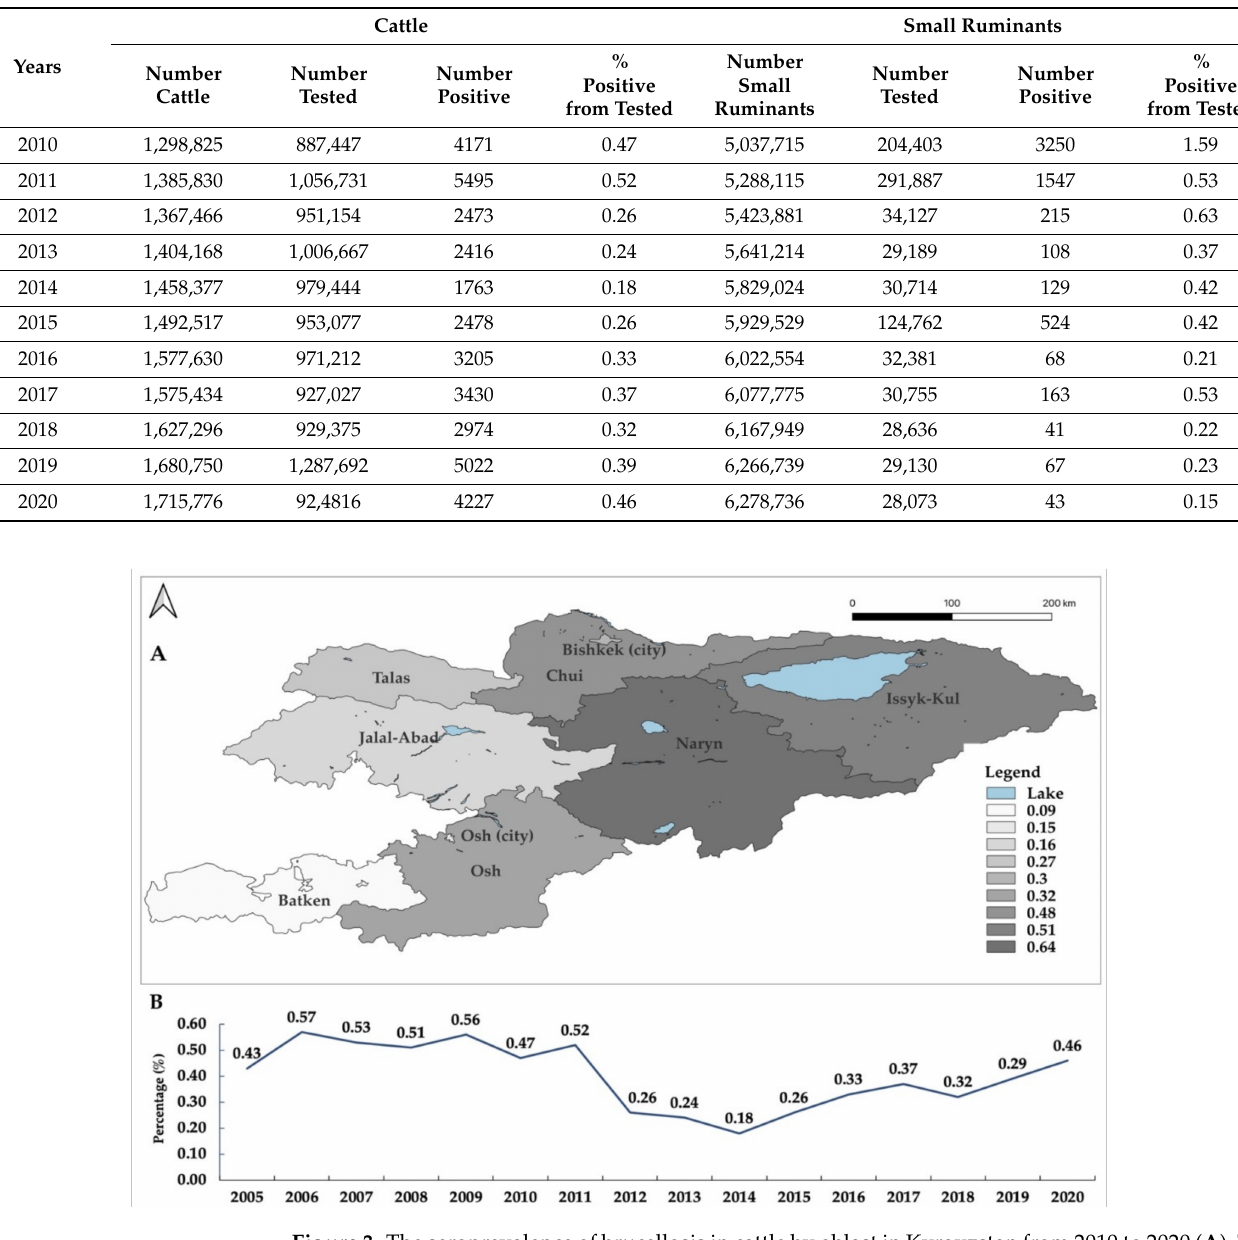
Figure 3. The seroprevalence of brucellosis in cattle by oblast in Kyrgyzstan from 2010 to 2020 ( A ). The seroprevalence of brucellosis in cattle from 2005 to 2020 ( B ). Cattle was positive in two consecutive Rose–Bengal plate test and/or serum agglutination test, based on reports from the SIVPS. The map was created using QGIS 3.22 Białowie˙za software which is available online